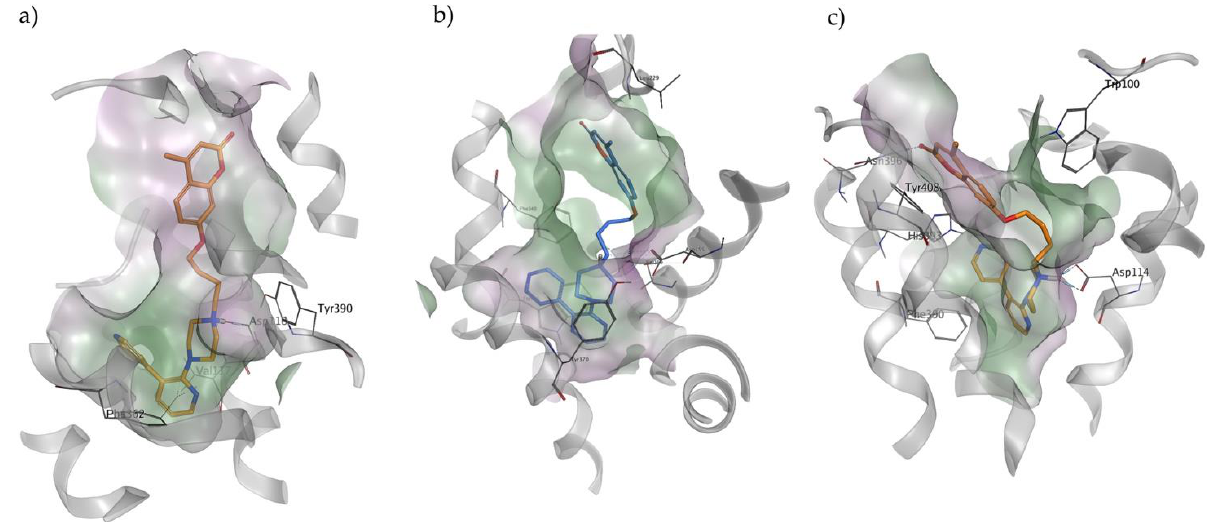
Figure 4. Docking poses of compound 12b at ( a ) serotonin 5-HT 1A receptor; ( b ) serotonin 5-HT 2A receptor; ( c ) dopamine D 2 receptor.